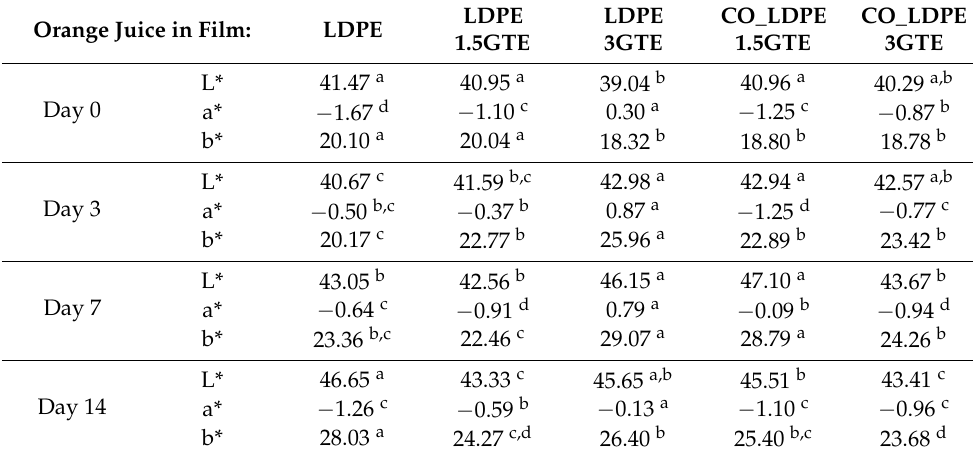
Table 2. The color parameters obtained for orange juice packaged in active LDPE films containing GTE at different days of